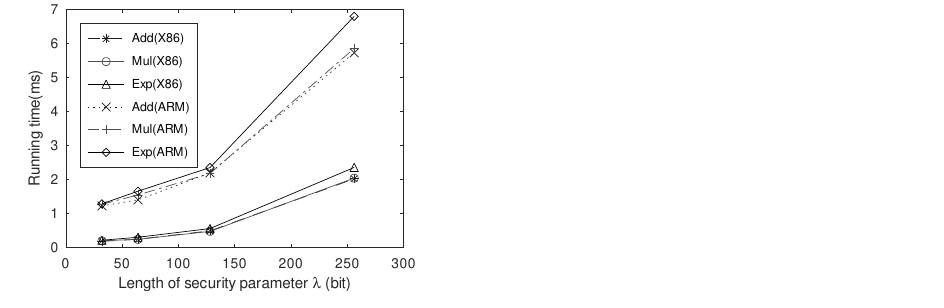
Figure 2. The running time comparison of additive, multiplicative and exponential arithmetic operations of LPCP on ARM and X86